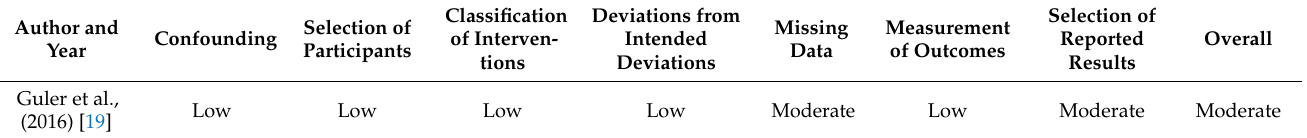
Table 5. ROBINS-I (risk of bias judgements in nonrandomized studies of